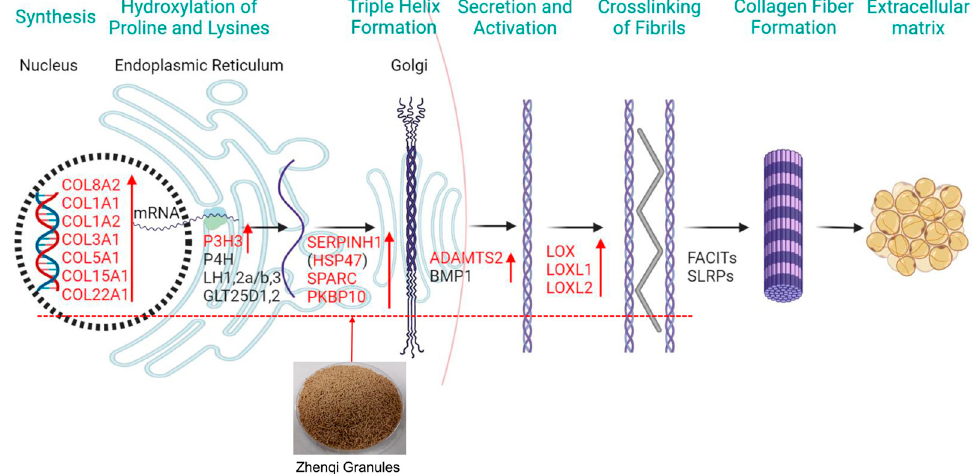
Figure 6. Collagen biosynthesis. Note: COL, collagen; P3H3, prolyl 3-hydroxylase 3; P4H, prolyl-4-